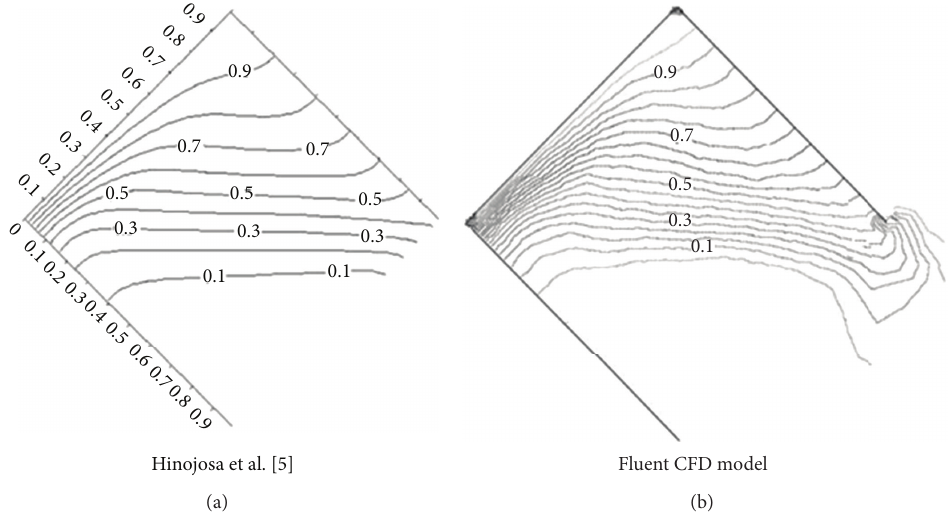
Figure 2: Comparison of temperature profiles at the midplane of the cavities at 45 ∘ inclination and Rayleigh number of 10 5 .